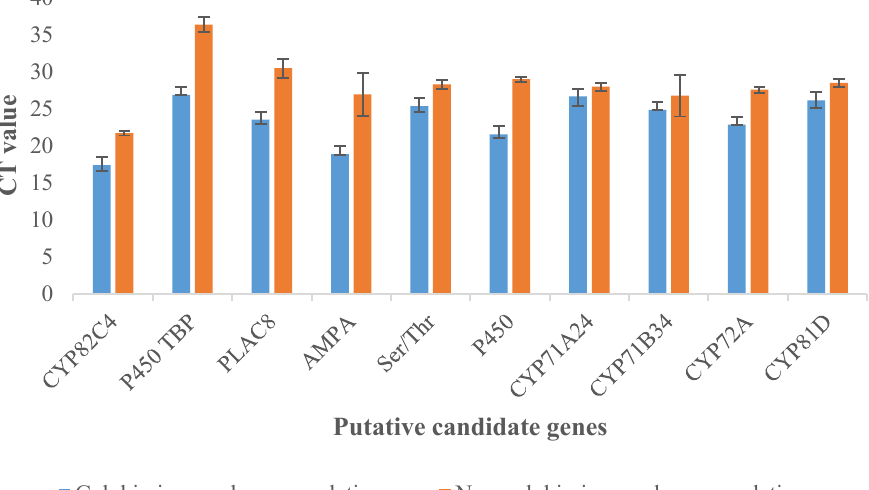
Figure 8. CT values of leaves of galphimine producer plants (GP) and non ‐ galphimine producer plants (NGP) obtained by quantitative PCR analysis. AMPA (5’ ‐ AMP ‐ activated protein kinase), Ser/Thr (serine/threonine ‐ protein kinase AtPK2/AtPK19).